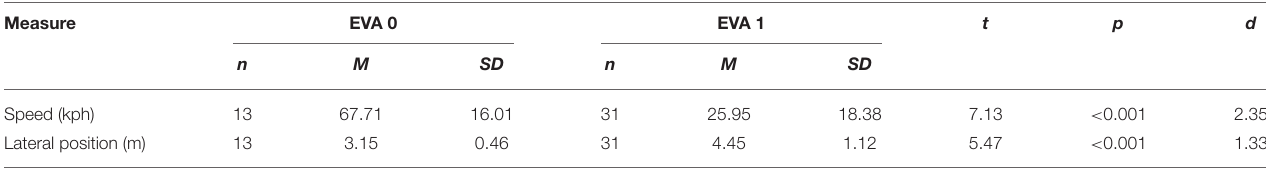
TABLE 2 | Descriptive statistics for the experimental and control groups, respectively, and inferential statistics for the differences, for only those participants who gave way by moving more than 3m from the road center. Measure EVA 0 EVA 1 t p d n M SD